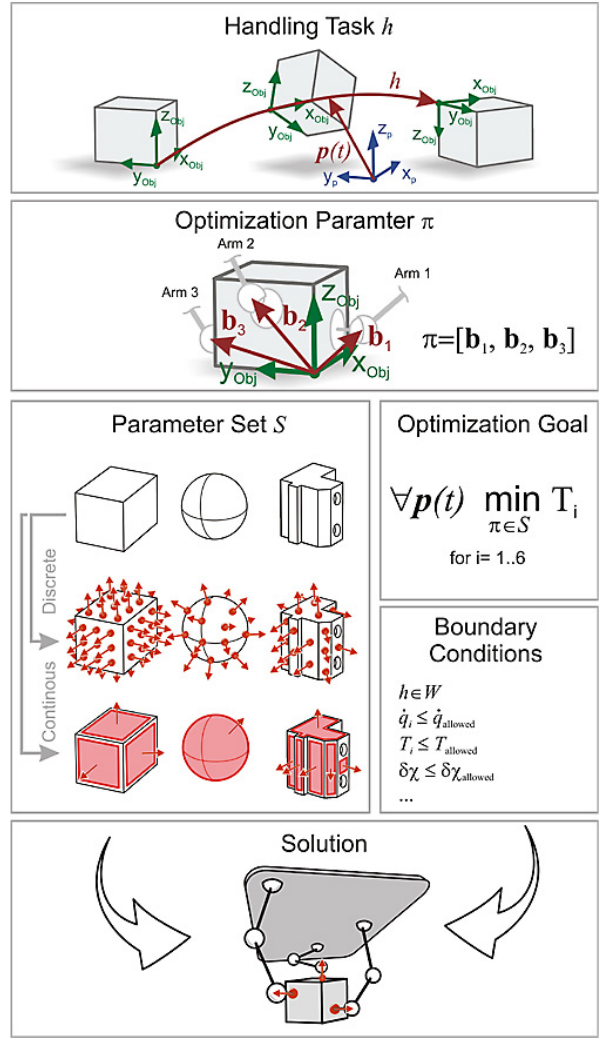
Figure 18. Grasp point optimization for e.g. minimizing drive